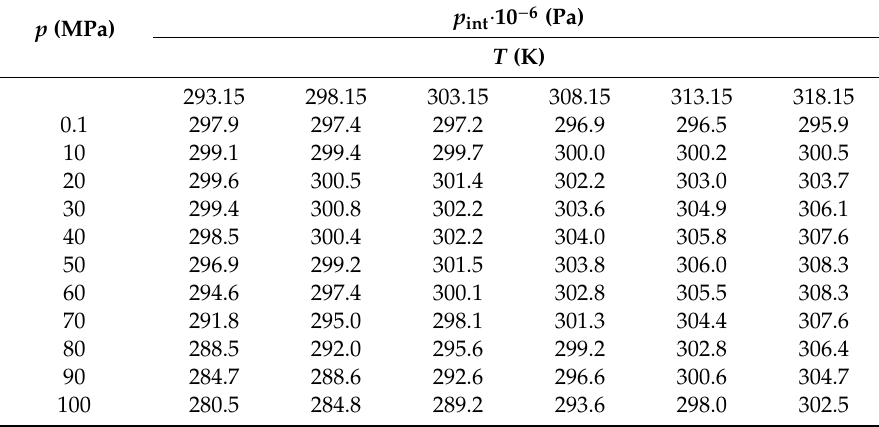
Table 11. The internal pressure, p int , of 1-butanol at pressures up to 100 MPa and within the temperature range from (293 to 318) K.